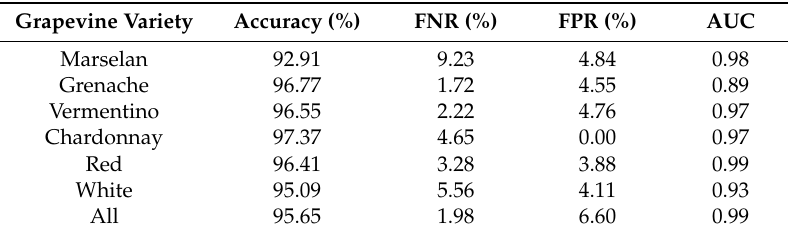
Table 5. Results of using complete spectra in classifying different groups of spectral data acquired in the August and September acquisition campaigns (Severity of infestation = 1 &